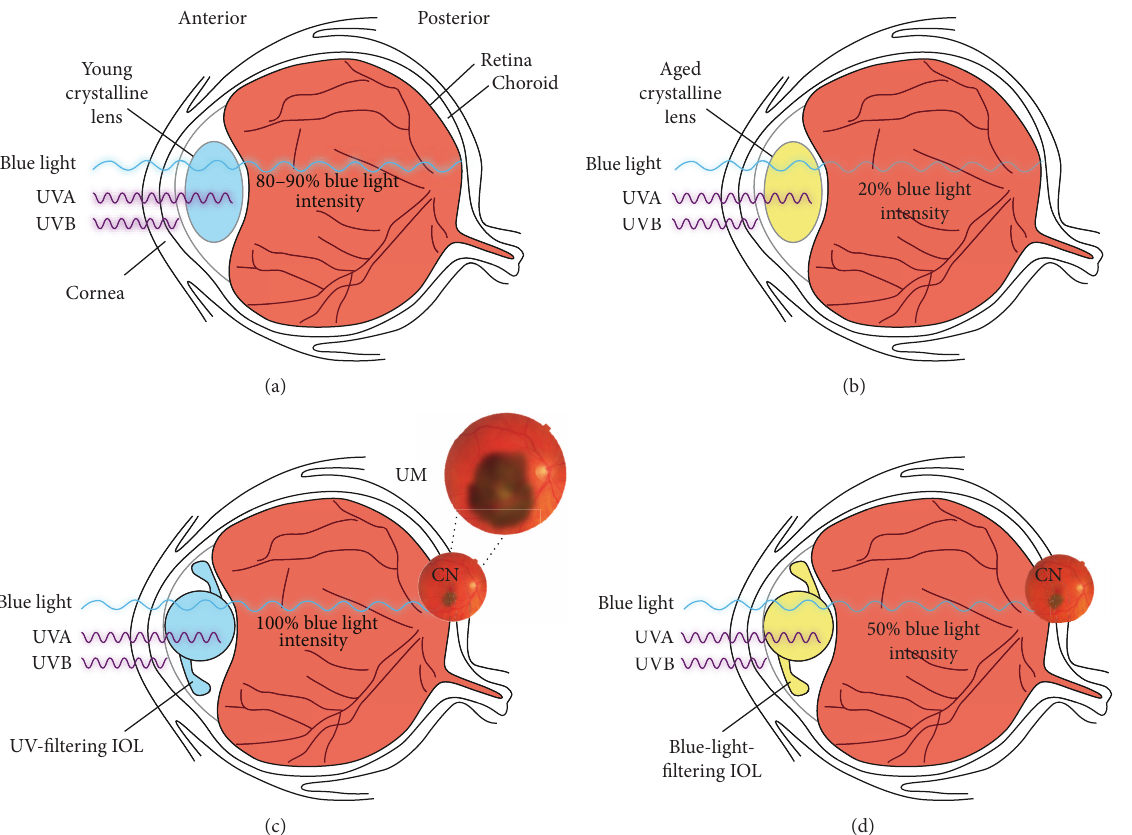
Figure 1: (a) The young crystalline lens and cornea together filter UVA and UVB while allowing transmission of most blue light (defined as 400–500 nm) to the retina. Around 80–90% of blue light at 450 nm can pass through the young lens. (b) As the crystalline lens ages it yellows and progressively filters more blue light until, by the sixth or seventh decade, blue light transmission can be as low as 20% of that transmitted by the young lens. (c) Early types of IOLs used to replace the crystalline lens during cataract surgery effectively filter UV but do not block blue light. It is hypothesized that blue light reaching the retina increases the risk of preexisting dysplastic nevi (indicated as CN, choroid nevus) progressing to UM. A typical CN is shown in the small retinal photograph, while a UM is shown in the magnified retinal photograph. (d) Blue-light-filtering IOLs are designed to filter up to 50% of blue light. This models the natural filtering ability of the middle-aged eye, reducing potentially damaging radiation while not impacting on vision. We argue that preexisting CNs (shown in the small retinal photograph) are less likely to progress to UMs in this environment. CN, choroidal nevus; IOL, intraocular lens; UM, uveal melanoma; UV, ultraviolet; UVA, ultraviolet A; UVB, ultraviolet